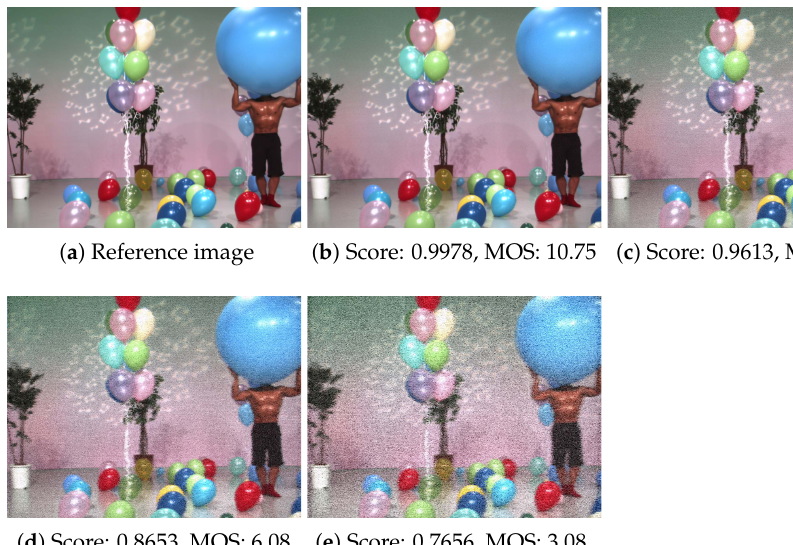
Figure 2. Results of the proposed quality assessment metric on sample images from the test dataset. ( a ) Original reference image, ( b – e ) are the images generated using DIBR from color and depth images polluted with additive white noise (AWN) at four different levels, with noise control parameters 5, 17, 33, and 53, respectively. The objective quality scores estimated by the proposed method and the subjective scores of these images are shown below